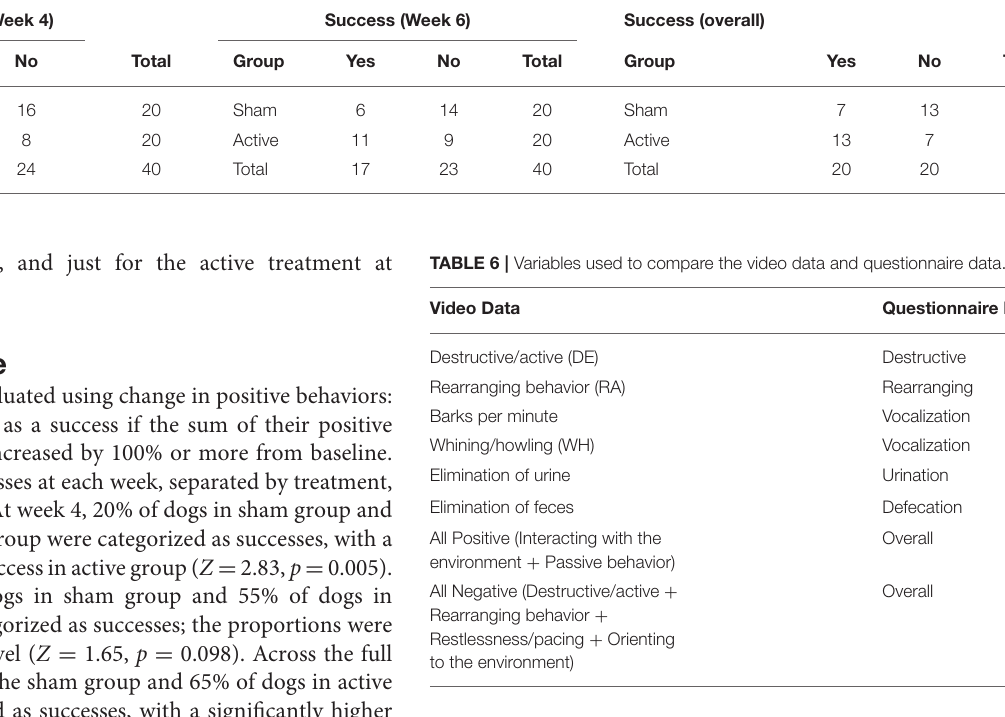
TABLE 5 | Distributions for the number of dogs in categories of success/failure (defined as an increase of 100% or more in positive behaviors compared to baseline) separated by treatment (sham or active) and time (week 4, 6, and overall across the study). Success (Week 4)